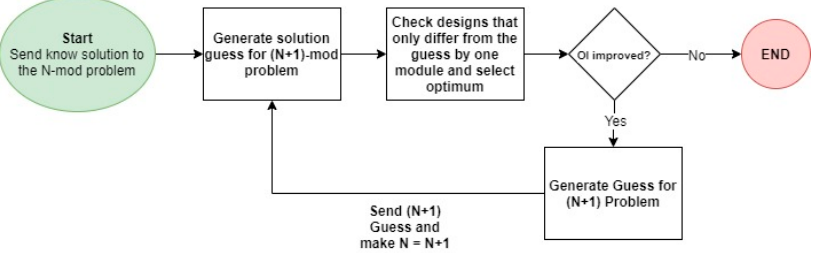
Figure 9. Algorithm for finding the optimum design for an N-mod problem given a known solution to a smaller (N − 1)-mod problem and that N is sufficiently large. This algorithm is referred to as the “Shortcut Method”.